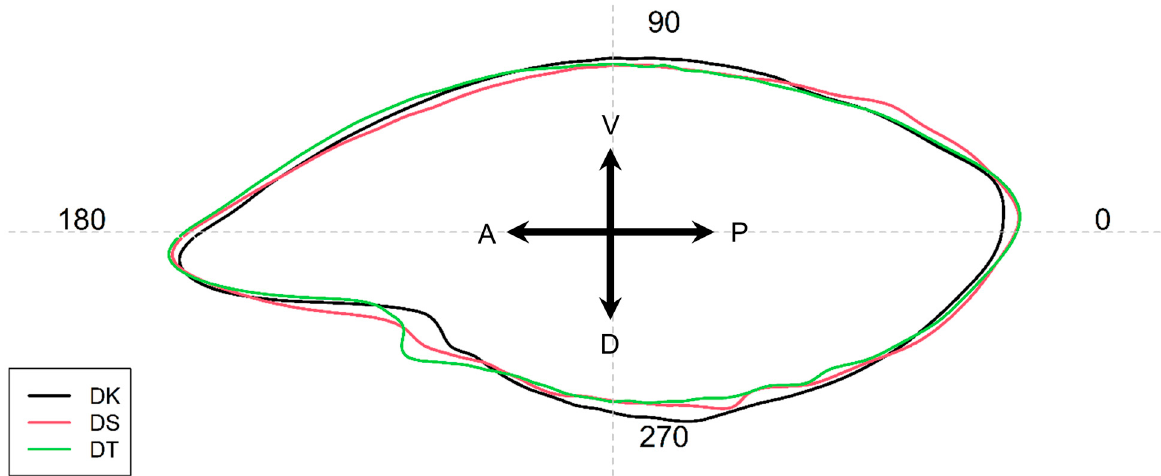
Figure 5. Mean otolith shapes of Decapterus kurroides (DK), D. smithvanizi (DS), and D. tabl (DT) based on wavelet reconstruction, extracted using the “detect.outline” function of ShapeR. Crossmap shows the position of the otolith, as in Figure 3.